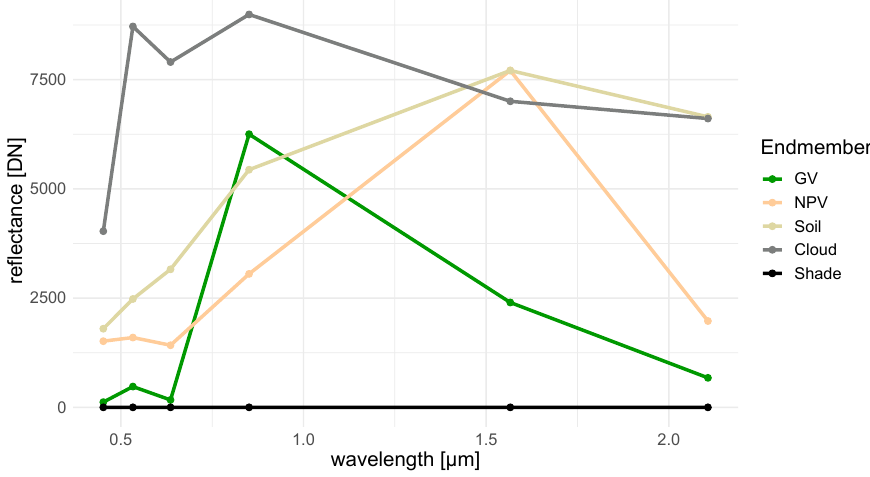
Figure 4. Reflectance curves of used spectral endmembers (data from